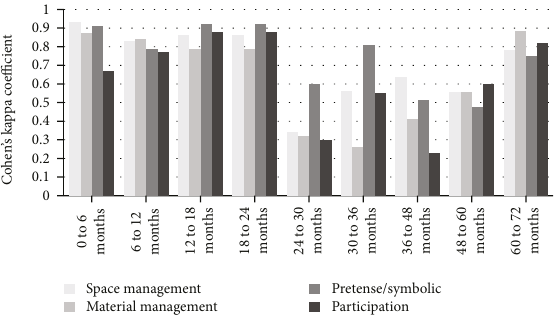
Figure 1: Intrarater agreement for rater 1.